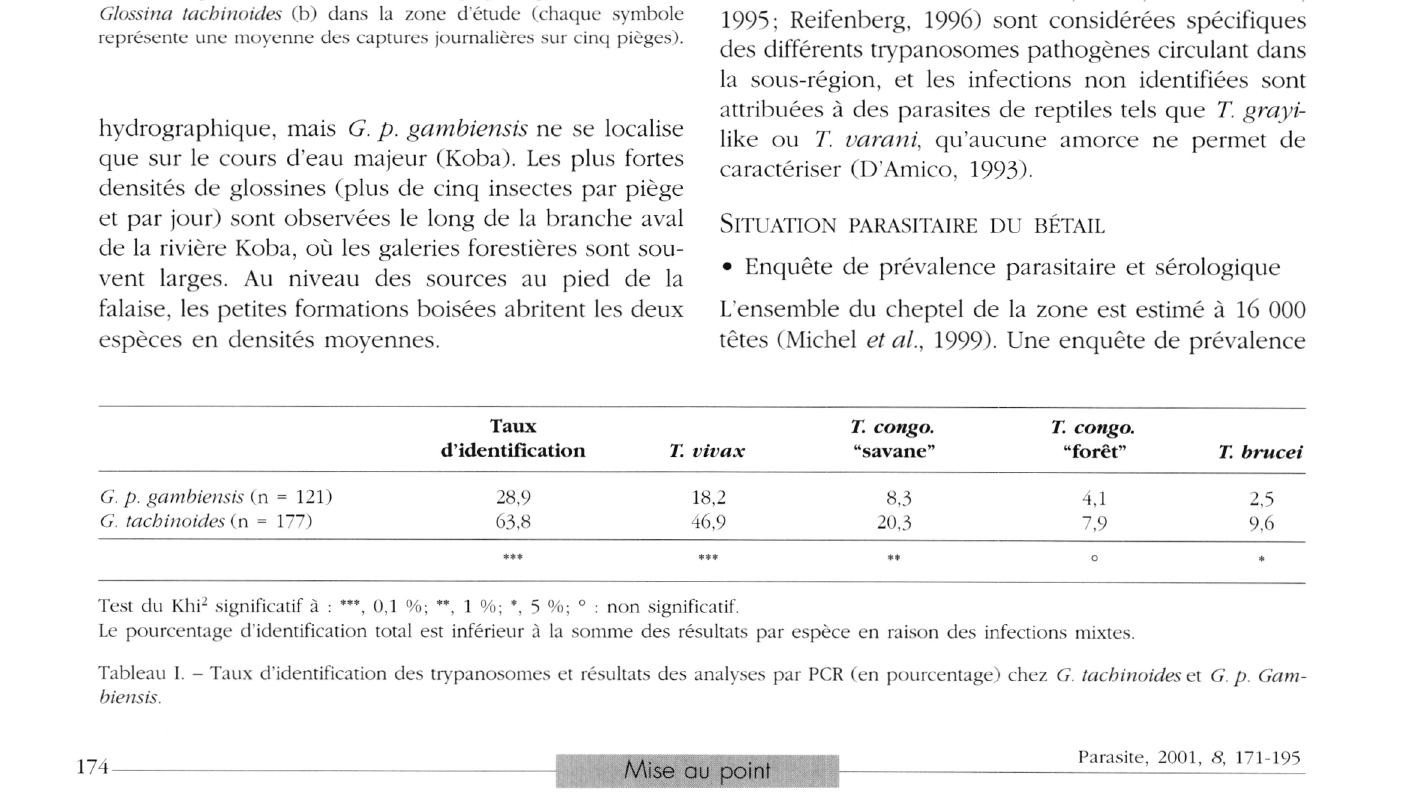
Fig. 3. - Répartition actuelle de Glossina palpalis gambiensis (a) et Glossina tachinoides (b) dans la zone d’étude (chaque symbole représente une moyenne des captures journalières sur cinq pièges).